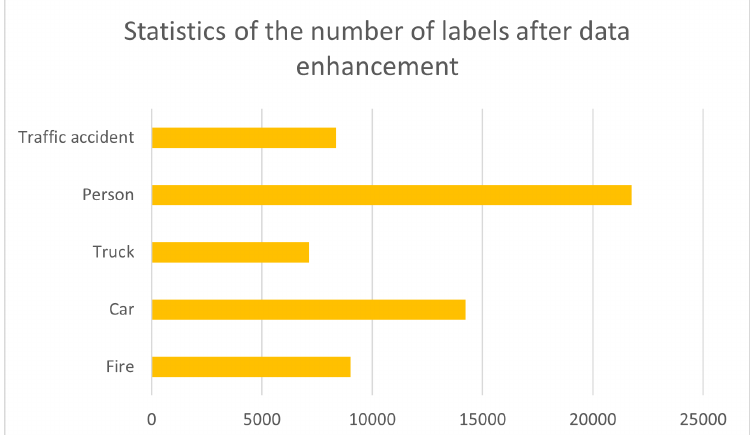
Figure 3. After directional data enhancement, the number of labels of different